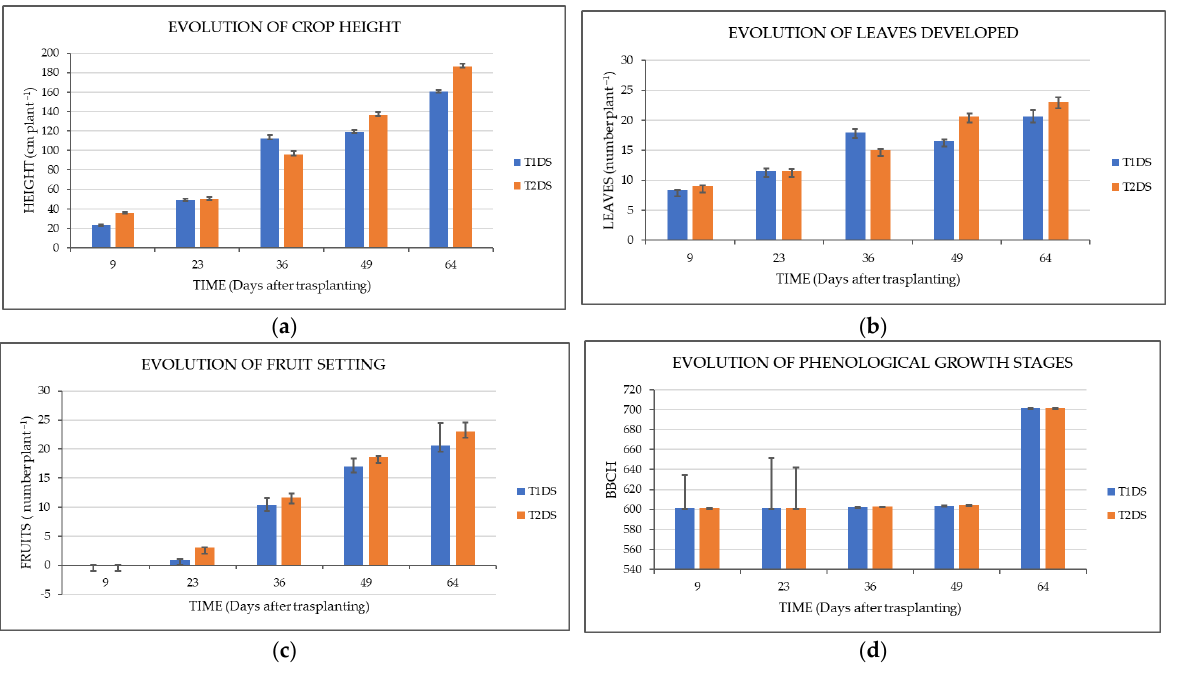
Figure 6. Growth parameters of tomato crops grown in soil above PVC trays: ( a ) evolution of height; ( b ) evolution of leaves developed; ( c ) evolution of fruit setting; ( d ) evolution of phenological growth stages.